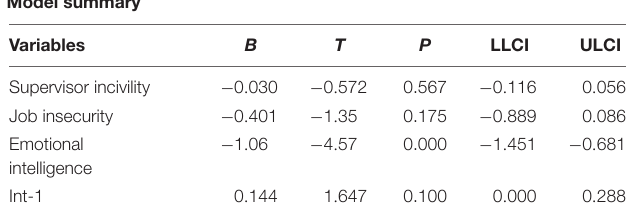
TABLE 9 | Model for Path